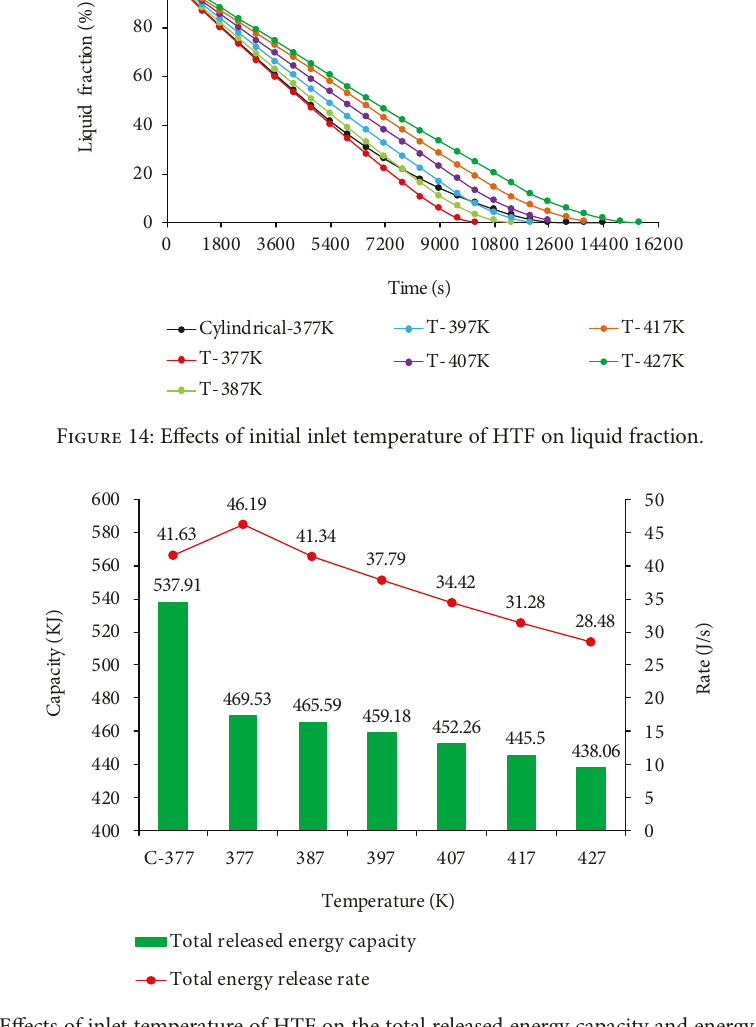
Figure 15: E ff ects of inlet temperature of HTF on the total released energy capacity and energy release rate.